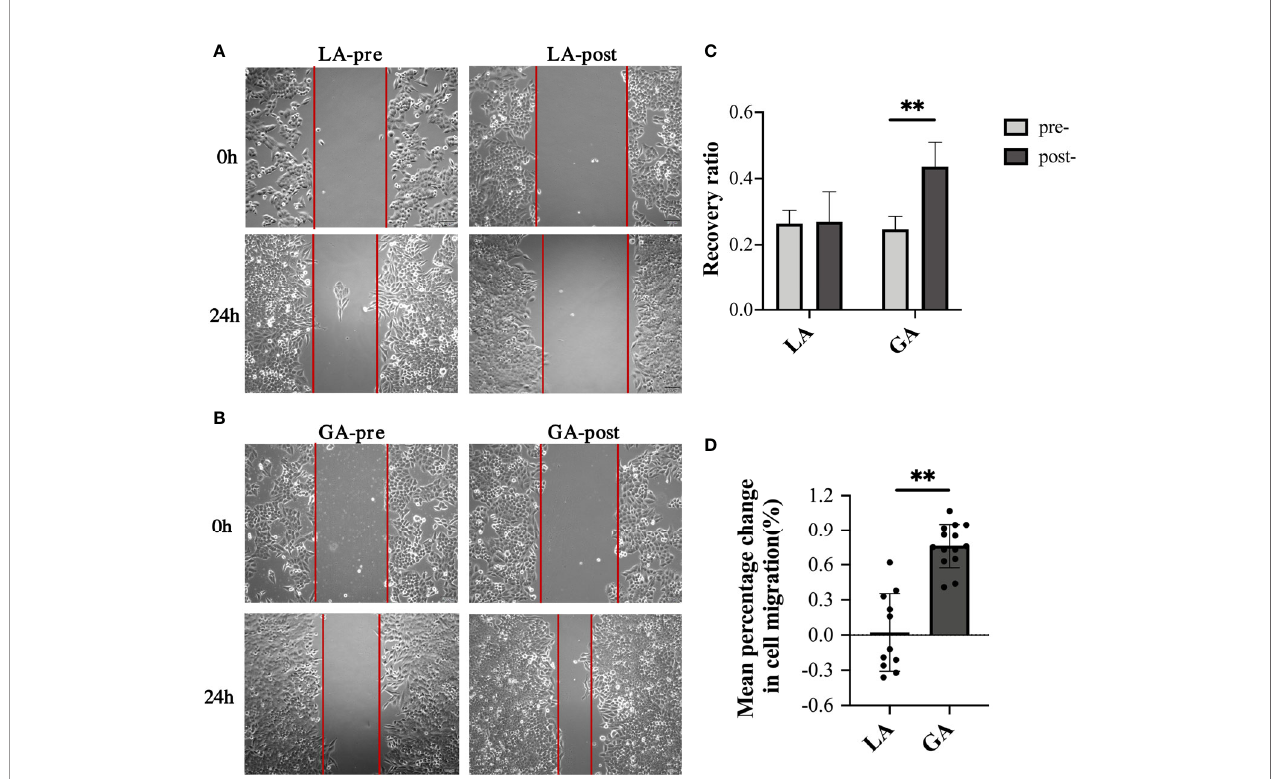
FIGURE 3 | Serum from RFA patients receiving GA facilitated cell migration of HepG2 cells. (A) Representative image of HepG2 cells cultured with preoperative or 1h postoperative serum from the LA group; (B) Representative image of HepG2 cells cultured with preoperative or 1h postoperative serum from the GA group; (C) Graphical representation of recovery ratios of the four groups in (A, B, D) Graphical representation of the mean percentage change from post- to preoperative values of recovery ratios in the GA group vs the LA group. Values are expressed as mean ± SD. n =11, LA group. n = 14, GA group. ** P < 0.01. GA, General Anesthesia; LA, Local